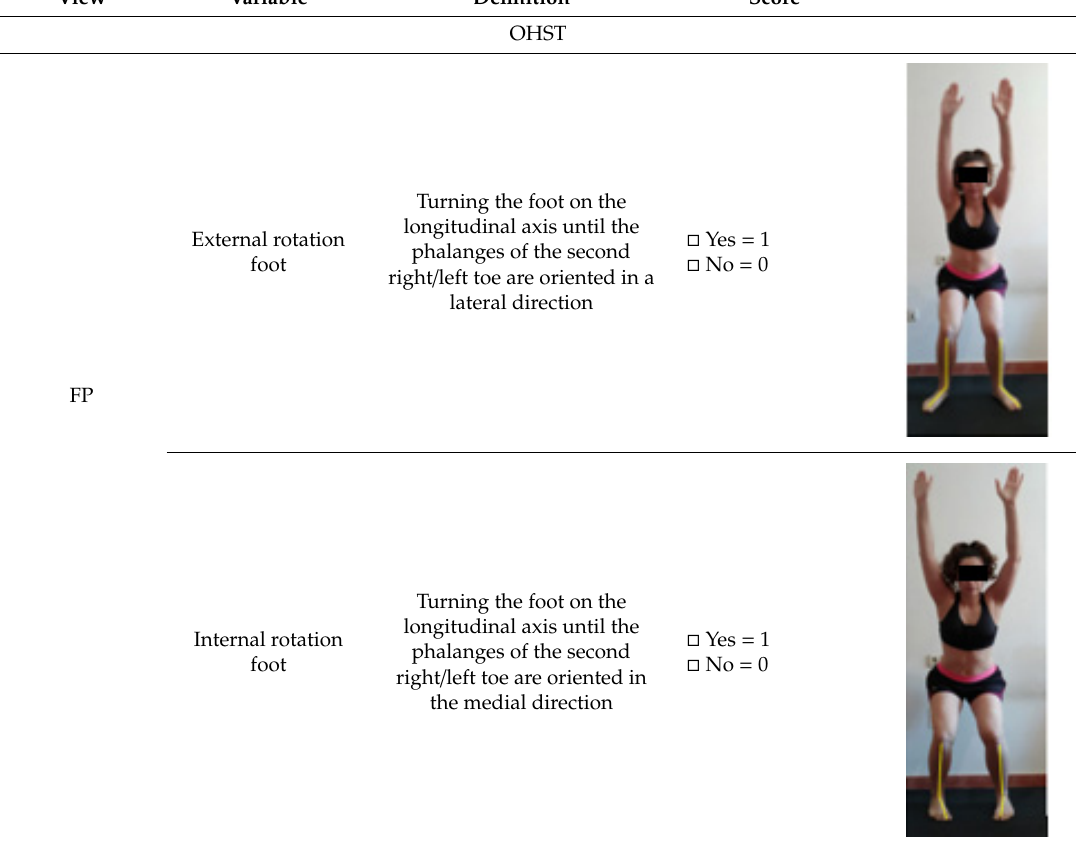
Table A1. Summary of variables with definition and graphic image.